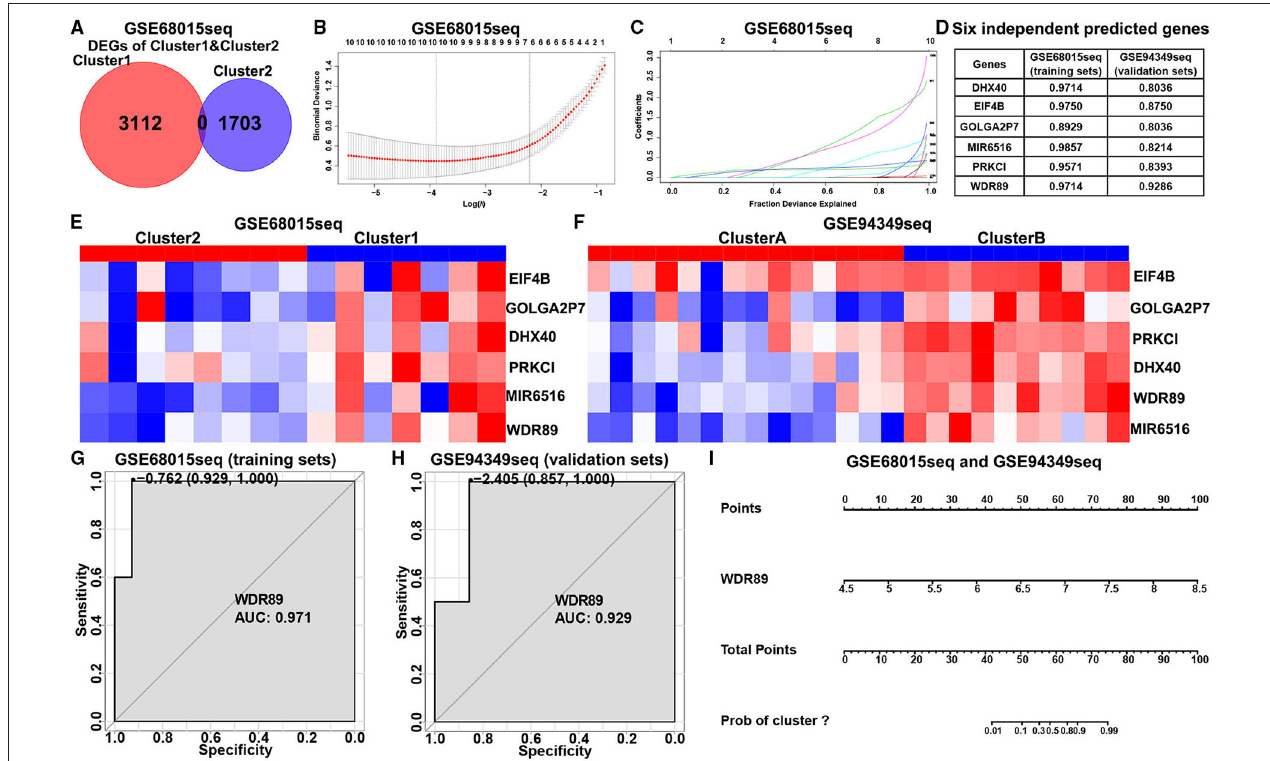
FIGURE 8 | Construction of the classification prediction model. (A) Venn diagram showed the DEGs between-group cluster 1 and cluster 2 ACPs in the GSE68015 database. (B) LASSO coefficients profiles of 4,815 DEGs in the GSE68015 database. (C) LASSO regression with tenfold cross-validation obtained optimal prognostic genes using minimum lambda value. (D) Logistic analysis was used to evaluate the best six independent predicted genes. (E,F) Heatmap of the expression profiles of the six independent predicted genes between cluster 1/2 and cluster A/B in the GSE68015 and GSE94349 databases. (G,H) ROC curves showed WDR89-based predictive model could provide a more reliable classification assessment in the training sets (AUC = 0.971) and validation sets (AUC = 0.929). (I) WDR89-based nomogram model to predict the immune classification of ACPs in the GSE68015 and GSE94349